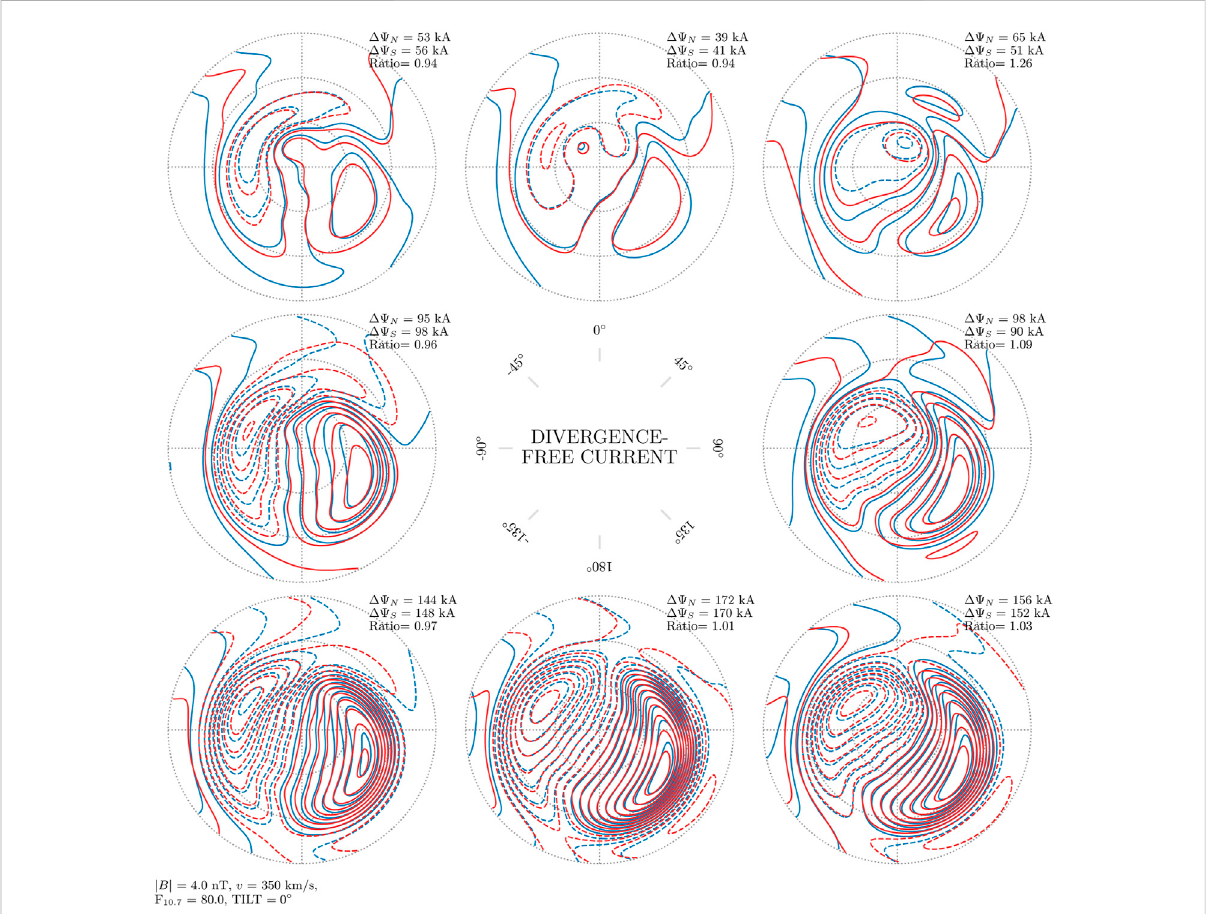
FIGURE 7 Divergence-free current function in the Northern and Southern Hemisphere as a function of IMF clock angle for dipole tilt angle ψ = 0 ° , in the same format as Figure 6. In this fi gure, the mean of the total currents in the Northern Hemisphere is 2% stronger than the mean total current in the Southern